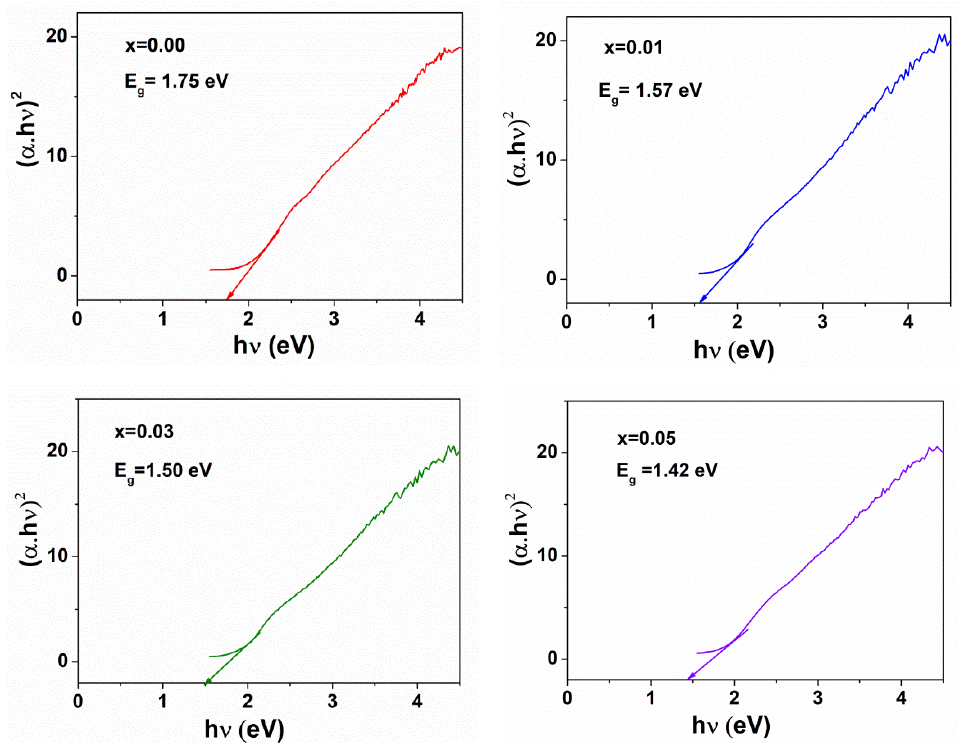
Figure 6. The band gap energies of ZnNd x Fe 2−x O 4 nanoparticles (x = 0.00–0.05).